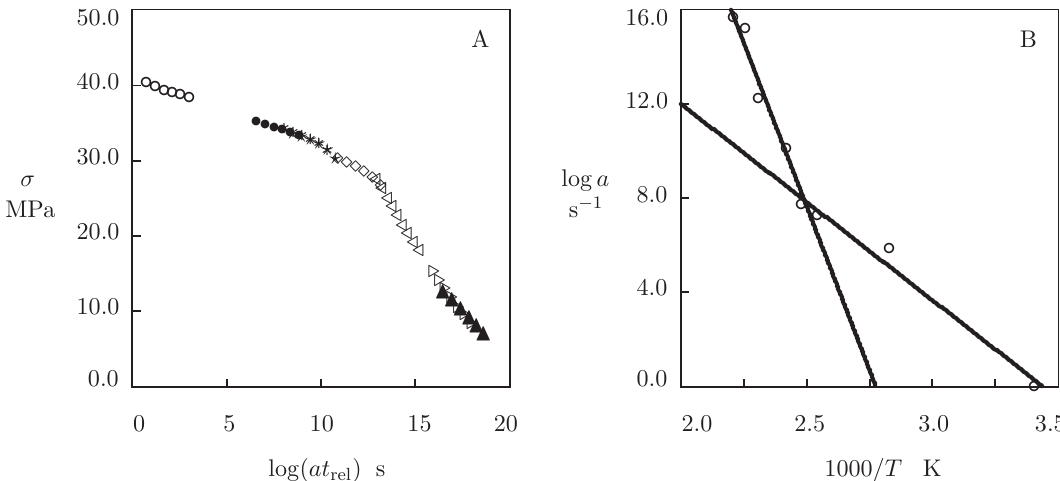
Figure 10. ( A )—Stress σ versus relaxation time t rel . Symbols: master-curve at room temperature constructed by shift of experimental data in relaxation tests. ( B )—Shift factor a versus temperature T . Circles: treatment of observations in relaxation tests. Solid lines: approximation of the data by Equation (16) with E a = 159.4 kJ/mol (low temperatures) and E a = 531.3 kJ/mol (high